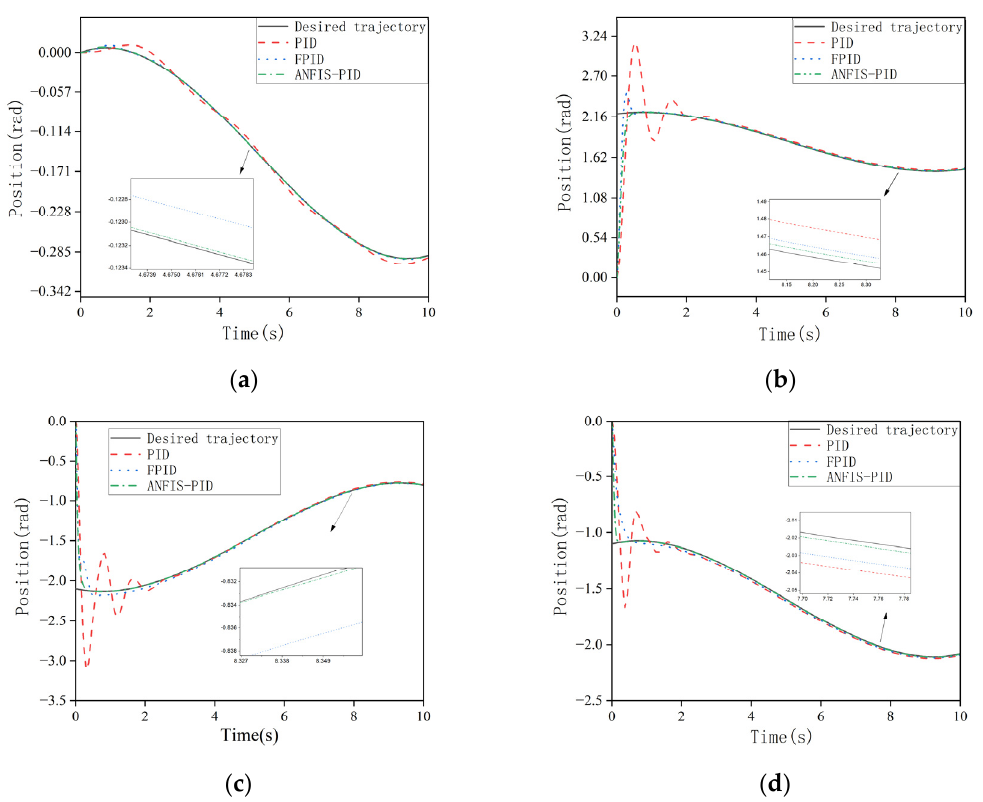
Figure 10. ( a ) Trajectory tracking for joint 1; ( b ) trajectory tracking for joint 2; ( c ) trajectory tracking for joint 3; ( d ) trajectory tracking for joint 4.